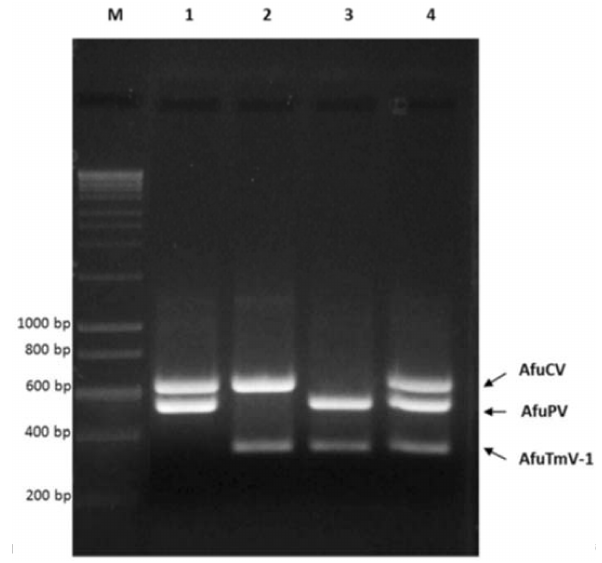
Figure 3. Simultaneous detection of A. fumigatus mycoviruses using multiplex RT-PCR. Mixed dsRNA combinations were used to perform multiplex RT-PCR. In lanes 1, 2 and 3, combinations of AfuCV and AfuPV-1, AfuCV and AfuTmV-1 and AfuPV-1 and AfuTmV-1, were used as template, respectively. In lane 4, dsRNAs belonging to three A. fumigatus mycoviruses were mixed and multiplex RT-PCR was performed using all three primer pairs. Hyperladder-I was used as a marker to estimate the size of the amplicon (Lane